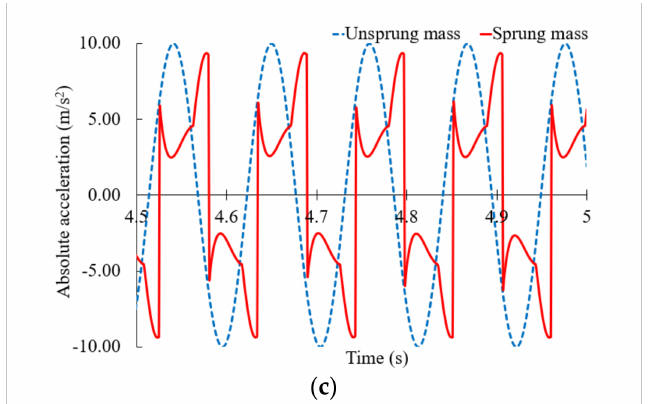
Figure 9. Response of the time domain of ( a ) displacement, ( b ) velocity, and ( c ) acceleration of the sprung and un-sprung mass with the excitation frequency equal to the natural frequency.